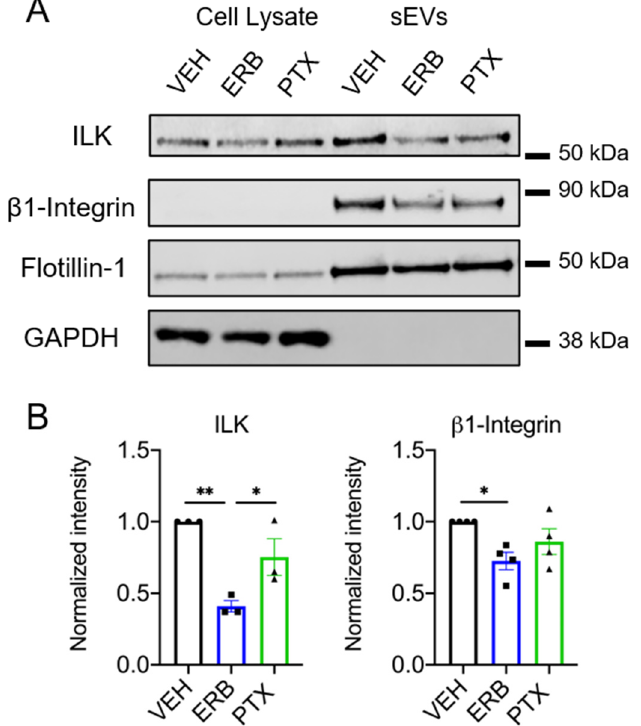
Figure 6. Effects of eribulin or paclitaxel on sEV-associated ILK and β 1-integrin. HCC1937 cells were treated for 8 h with vehicle, 25 nM eribulin, or 50 nM paclitaxel and sEVs were isolated from the conditioned media. ( A ) Representative immunoblots of the indicated proteins in 10 µ g of cell lysates and equal volumes of sEVs representing 42% (ILK, β 1-integrin, flotillin-1) or 7.5% (GAPDH) of the yield from 6–8 × 10 7 HCC1937 cells. ( B ) Band intensities for indicated proteins in sEV samples normalized to vehicle control sEVs. Points represent the results of independent experiments and bars the mean ± SEM, n = 3–4. Significance was determined among sEV samples by one-way ANOVA with Tukey’s post-hoc test, * p < 0.05 and ** p < 0.01.